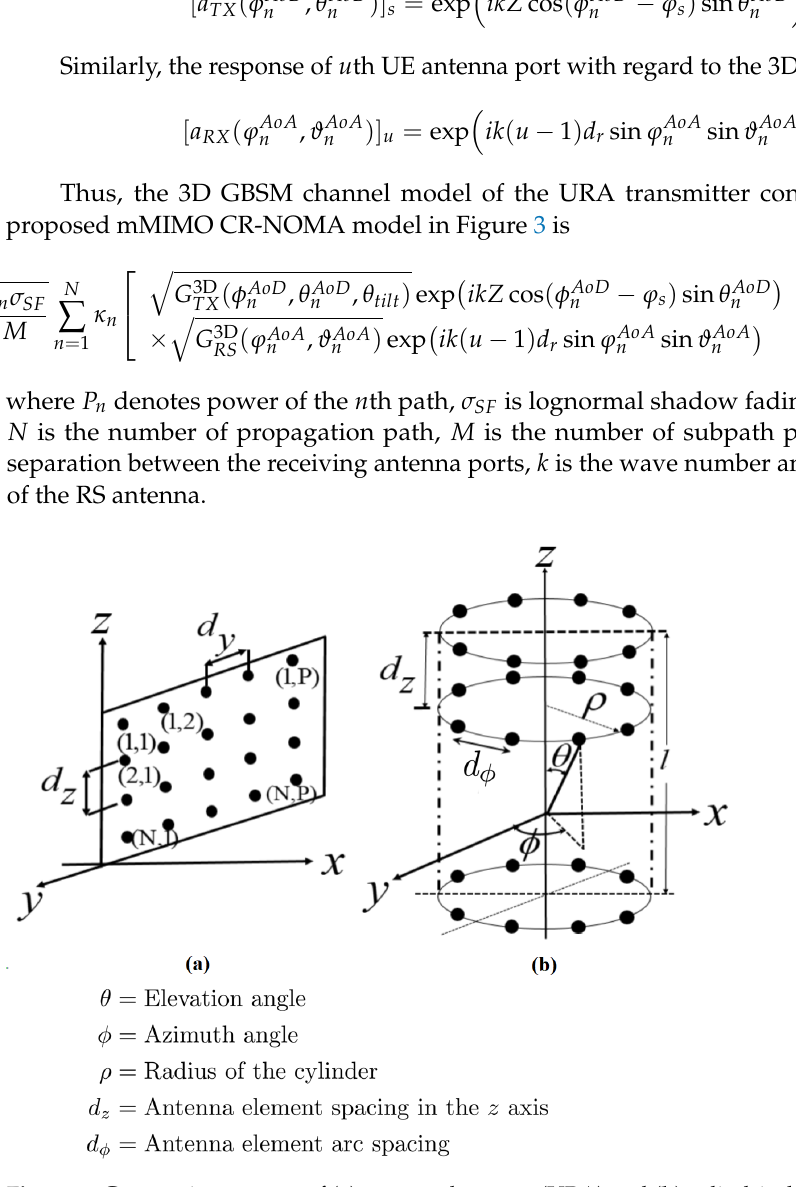
Figure 5. Geometric structure of ( a ) rectangular array (URA) and ( b ) cylindrical array (CA). In the case of CA, Figure 5b, considering the array dimension of CA as l = 4 λ with radius given by ρ = 4 λ / l , if d z = 4 λ / M is the wavelength distance in meters between antenna elements on the first and second position in the z direction. Then 4 λ ( m − 1 ) / M wavelengths may be used to estimate the placement of the third and following antenna components, where m = 1, ..., M is the number of antenna elements on a ring in the z -axis, and λ is the wavelength in meters. The angular position of the n th element of the m th of CA on the x-y plane is expressed as ϕ s = 2 π ( n − 1 ) / N . Consequently, the location vector